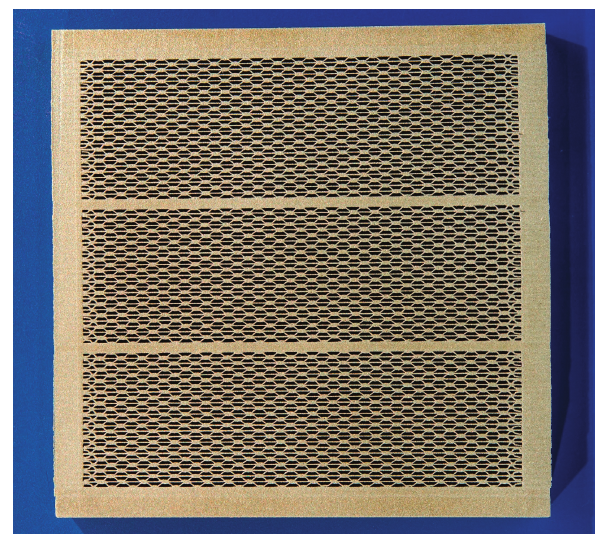
Figure 14 Cross cut view after vacuum brazing of the stacked plate